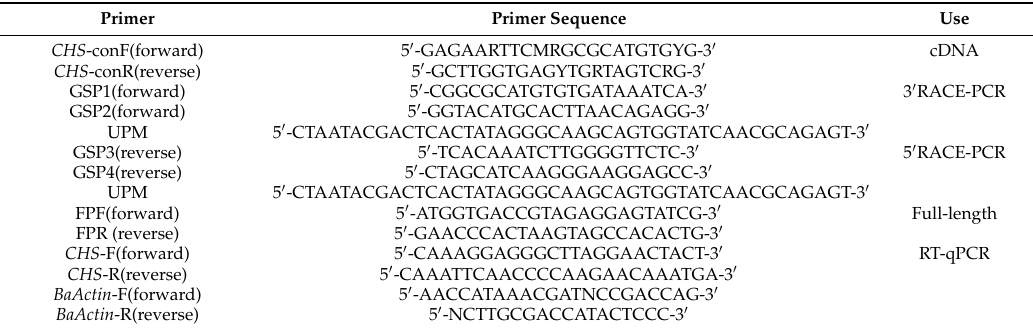
Table 1. Primers used in the study of BaCHS and RT-qPCR. Primer Primer